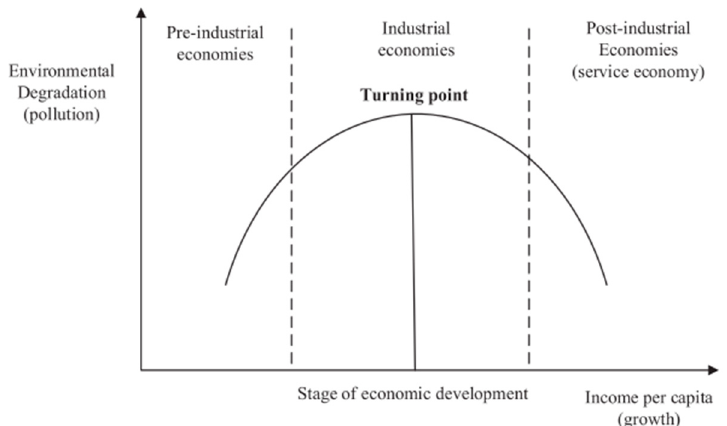
Figure A1. Environmental Kuznets curve. Source: Panayotou (1979).